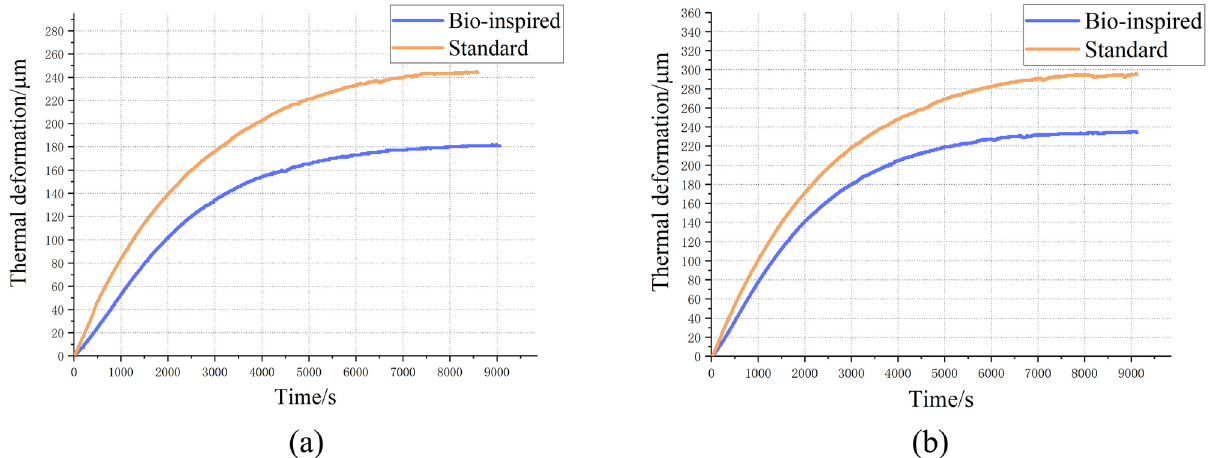
Figure 11: Thermal deformation comparison under various supply voltages: ( a ) 22 V; ( b ) 25 V.